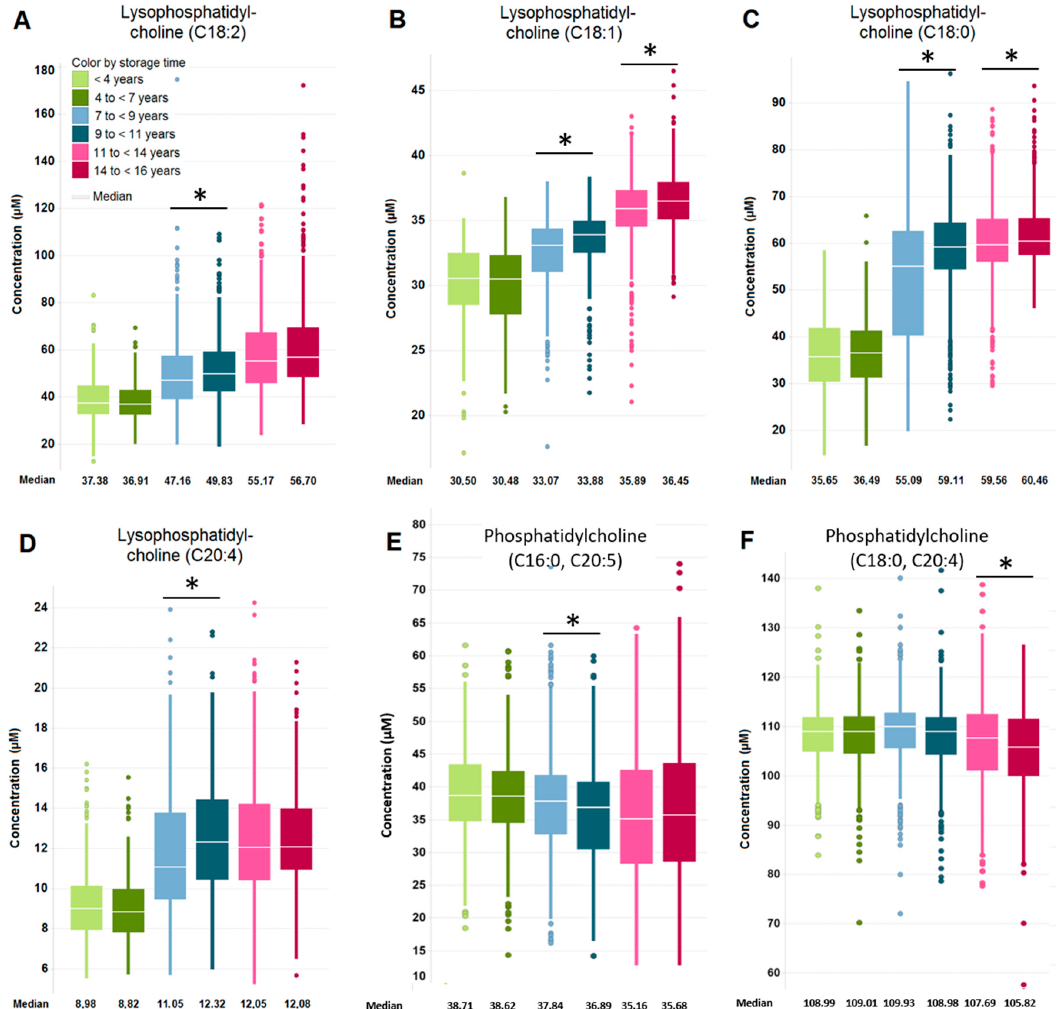
Figure 2. The effect of long-term storage at − 80 °C on selected LPCs and polyunsaturated fatty acids containing PCs represented by box plots. ( A ) LPC ( C 18:2), ( B ) LPC ( C 18:1), ( C ) LPC ( C 18:0), ( D ) LPC ( C 20:4), ( E ) PC ( C 16:0, C 20:5), ( F ) PC ( C 18:0, C 20:4). Asterisk denotes significant changes ( p < 0.05, FDR < 0.05) within subject age groups. The legend is displayed in ( A ). Samples from one subject age group are shown in shades of the same color: 70 years of age = red; 75 years of age = blue; 80 years of age = green.